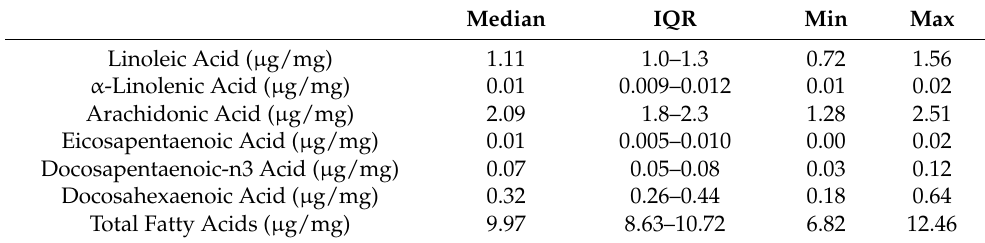
Table 4. Concentrations of PUFAs in Placenta.